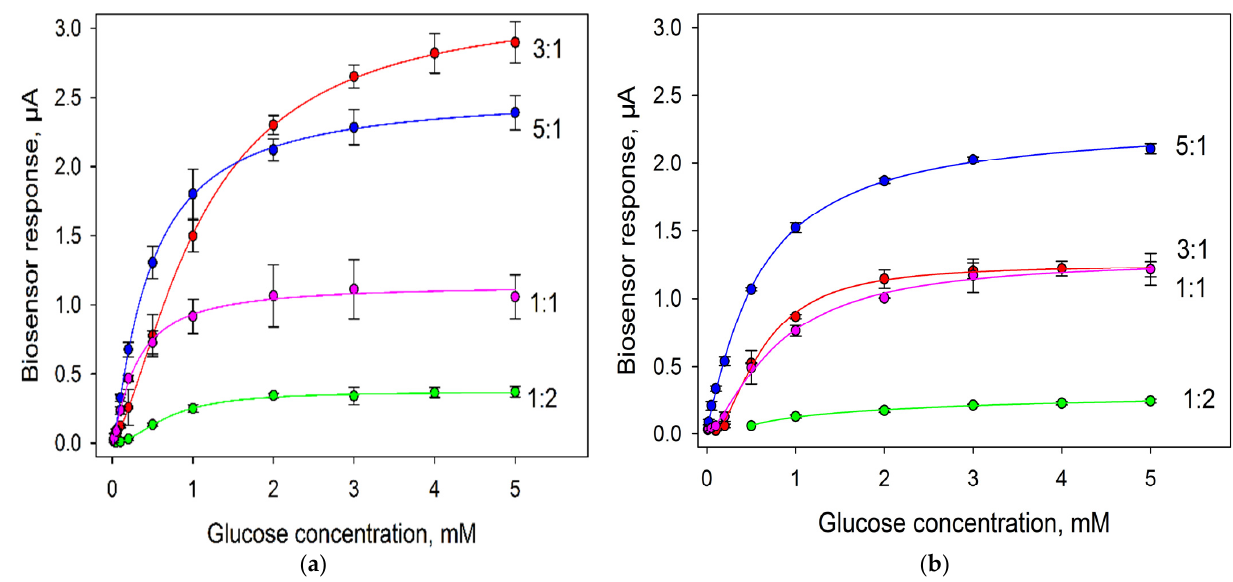
Figure 6. Calibration curves of glucose biosensors with various compositions of cells and Nafion on the surface of an electrode modified with PEDOT:PSS and graphene. Concentration of cells on the electrode surface, 0.3 mg/mm 2 : ( a ) day 1; ( b ) day 15. Table 1. Analytical characteristics of biosensors with different bacterial cells:Nafion